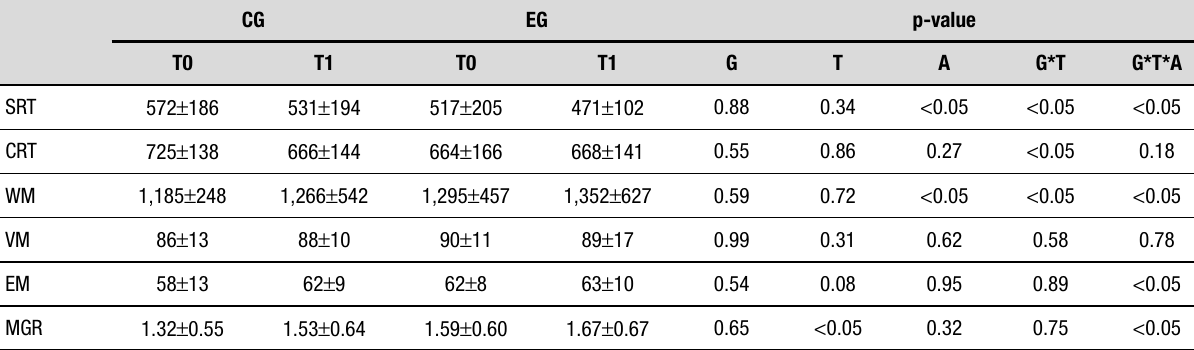
Table 3. Analysis of the cognitive assessments for memory under the effect of group, age and the interaction between group*time and group*time*age. CG EG p-value T0 T1